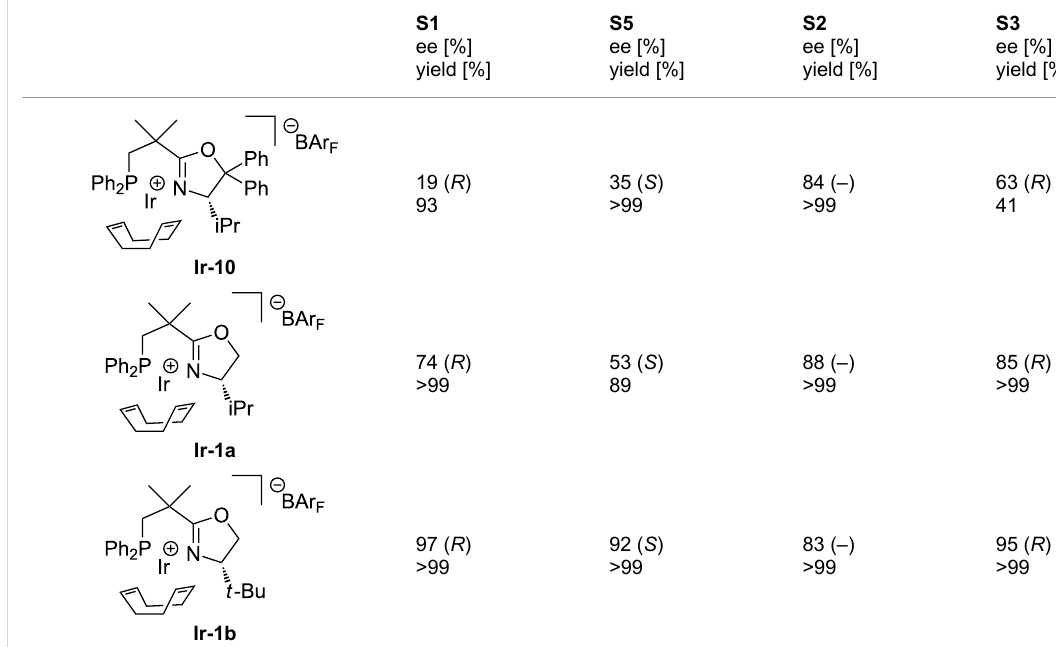
Table 1: Hydrogenation results employing 1st generation NeoPHOX catalysts.